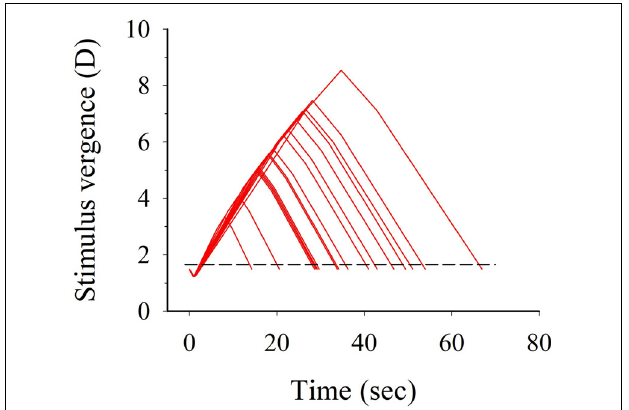
FIGURE 2 | Plots of stimuli (D) to convergence during conflicting stimulus-to-accommodation and stimulus-to-vergence eye-movements presented to the subjects during the two 10-min visual conditions Conv and Cc . The individual magnitude of stimulation to convergence eye-movements shown herein constitute 80% of the mean threshold value for diplopia (convergence break point). Figure only shows one cycle of